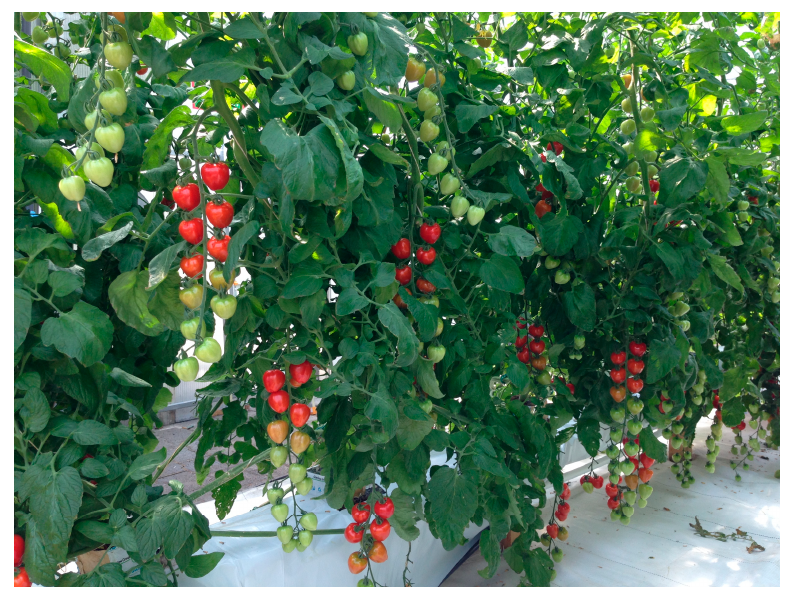
Figure A6. Tomato plants ( Solanum lycopersicum L. cv. ‘Gardenberry F1’ (Hild)) in summer 2014 in the Wädenswil aquaponic system.